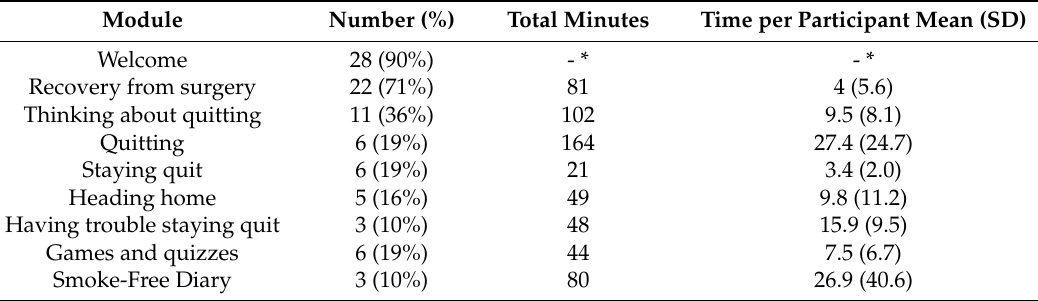
Table 2. Number of people, total and average time in minutes spent in each module during admission ( n =